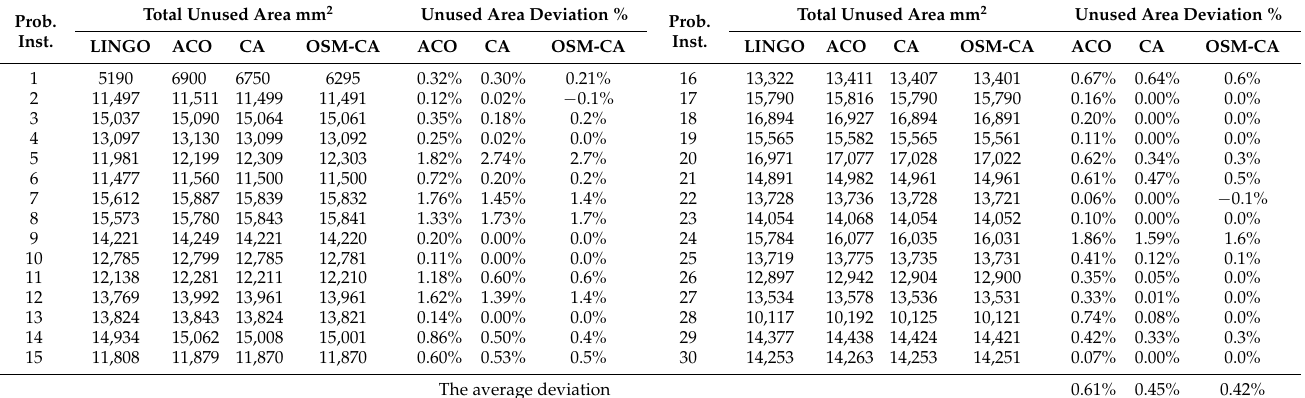
× 90 → = 720,000 mm 2 . x x